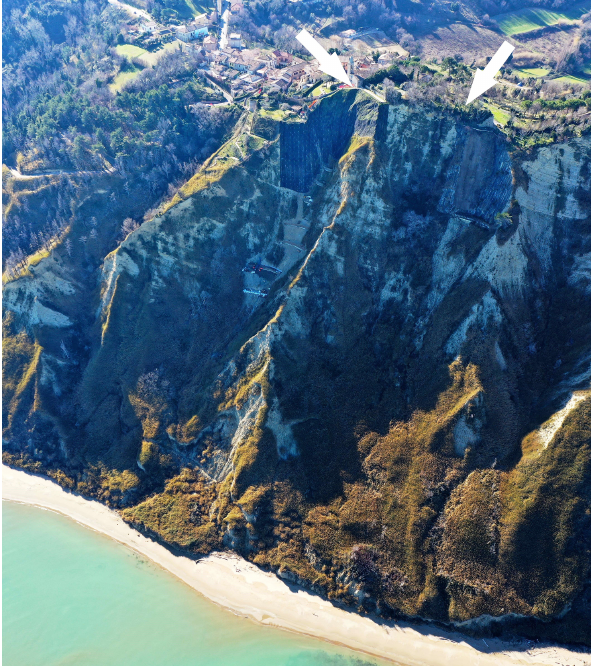
Figure 4. Panoramic view of the active cliffs of Mount San Bartolo. The cliff is oriented from NW (on the right) to SE (on the left). The small village of Fiorenzuola di Focara (at the top of the cliff) is 177m above sea level. The arrows indicate the landslide scarps.